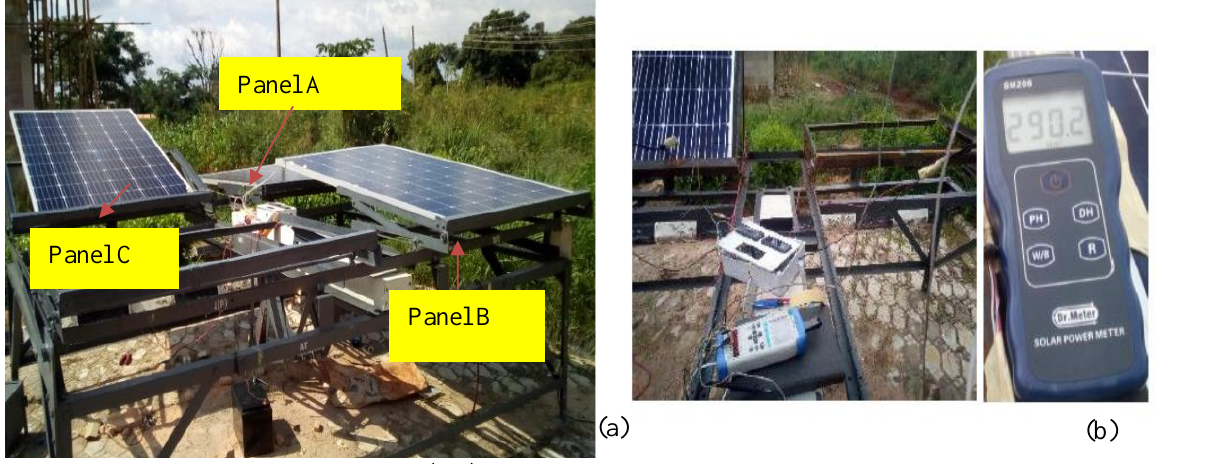
Figure 13. (a-b) Testing and Calibration of the prototype